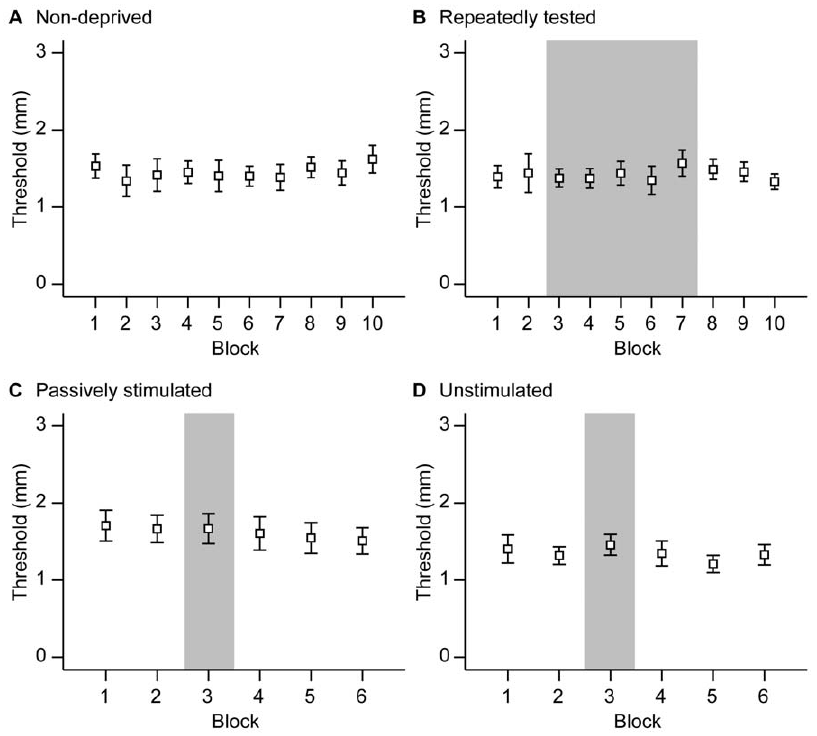
Figure 5. Experiment 2 data. GOT performance (mean 76% threshold) of the four groups (n=10 participants per group): A, non-deprived. B, repeatedly tested. C, passively stimulated. D, unstimulated. The shaded rectangles in B–D delineate the visual deprivation period. Errors bars represent 6 1 SEM.